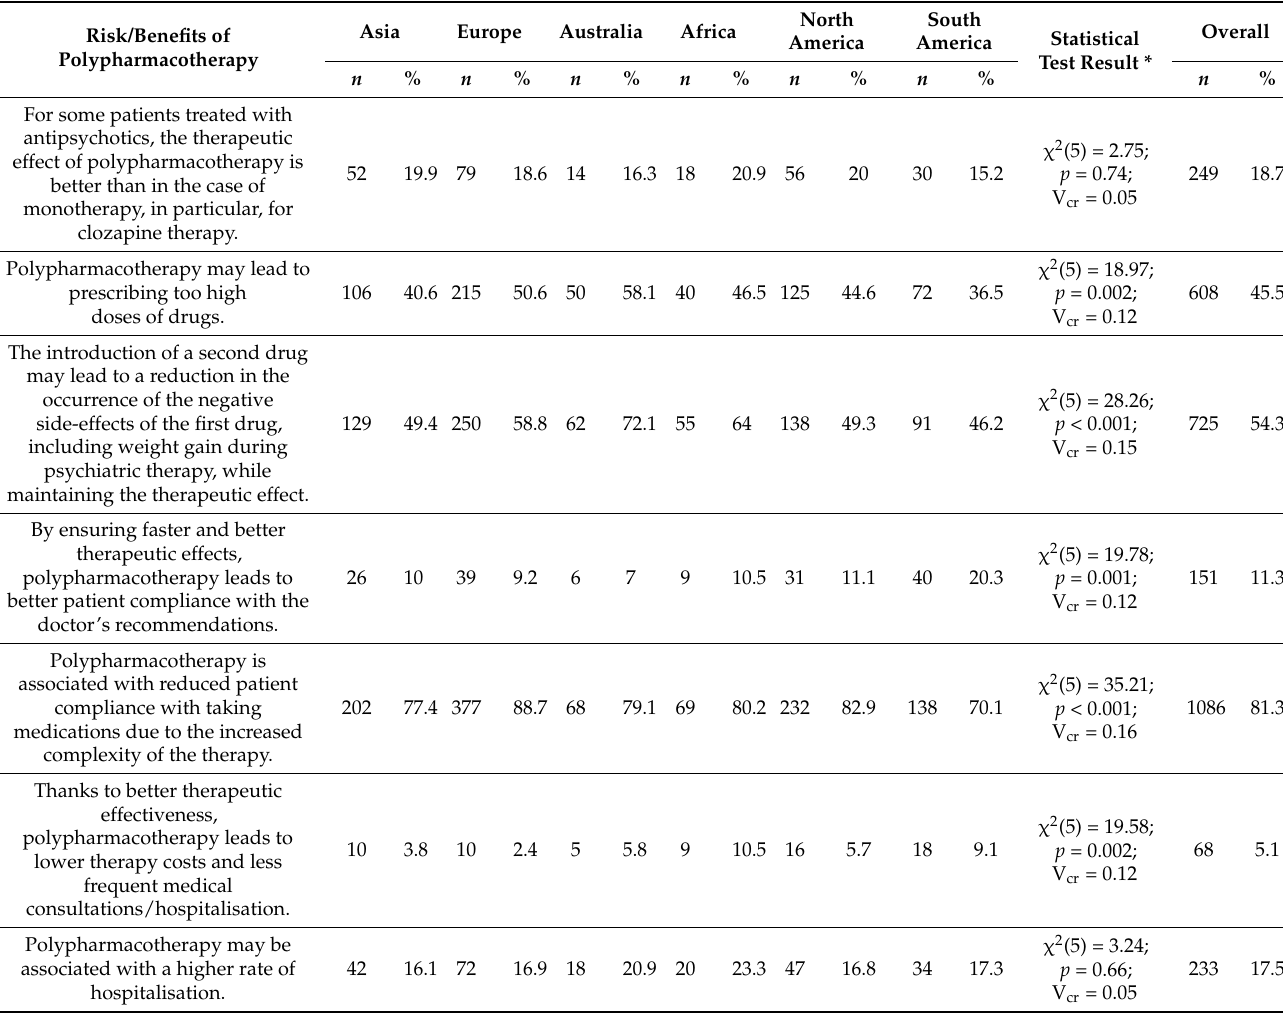
Table 9. Psychiatrists’ answers on the risk/benefits of